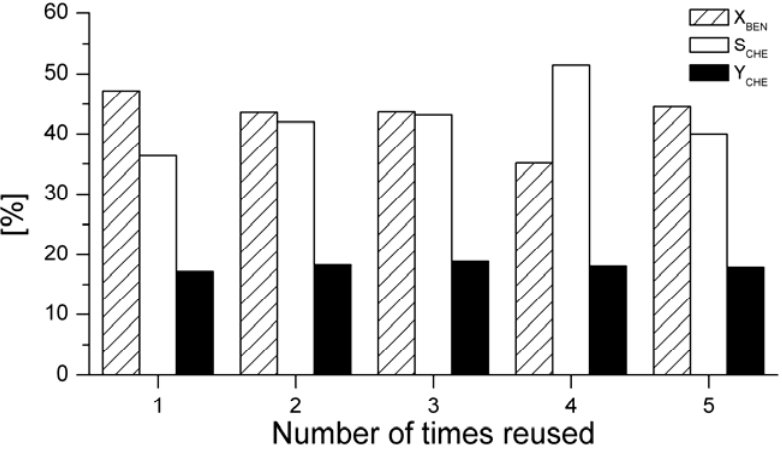
Figure 4. Recycling test of 2Ru/La 2 O 3 –ZnO. (Reaction conditions: 1.5 g 2Ru/La 2 O 3 –ZnO, 4 mg NaDCA, 20 bar H 2 , 100 mL H 2 O, 50 mL benzene, 1000 rpm, 150 °C, 330